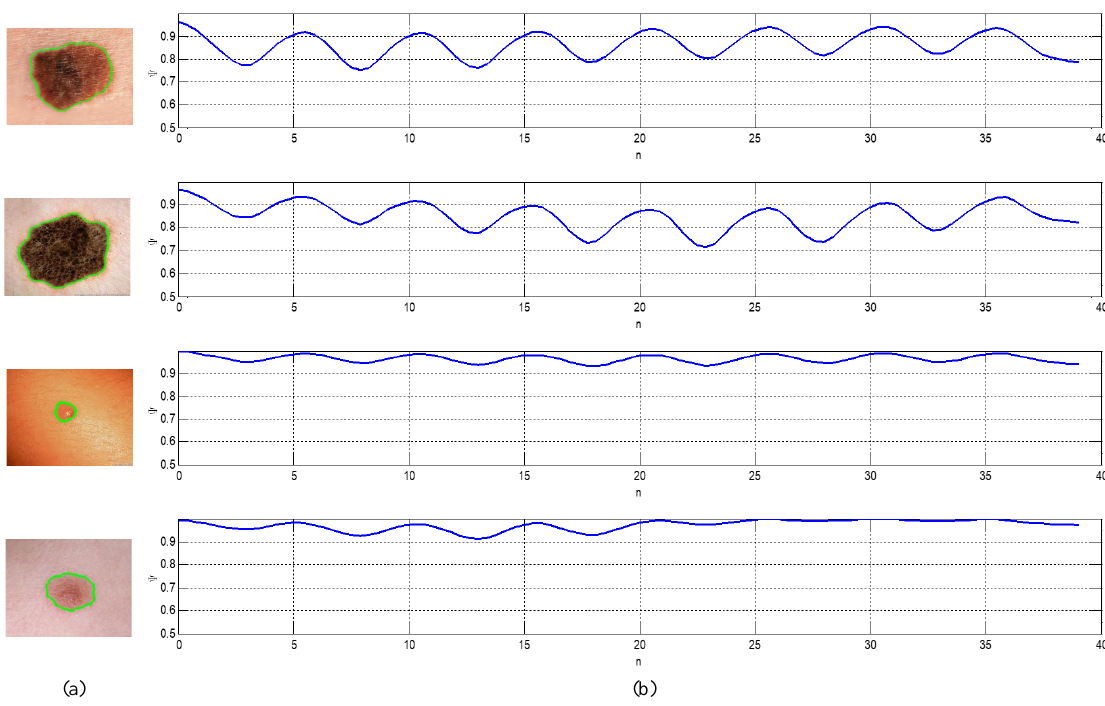
Figure 5. A sample of four skin lesion images and the plots of its local Gabor descriptors: ( a ) Original lesion image, ( b ) local Gabor descriptors; the first two dermoscopy images are malignant melanoma cases, while the other two images are benign lesions (from top to bottom,